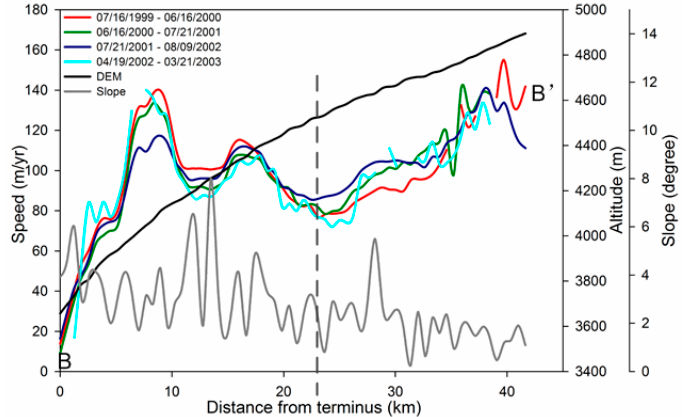
Figure 6. Annual speed profiles along the centerline (BB’) of the Siachen Glacier. The centerline location is indicated by the dashed line in Figure 5a. The gray dashed line marks the end-point location of the centerline profile for average velocity estimation in Table 2.